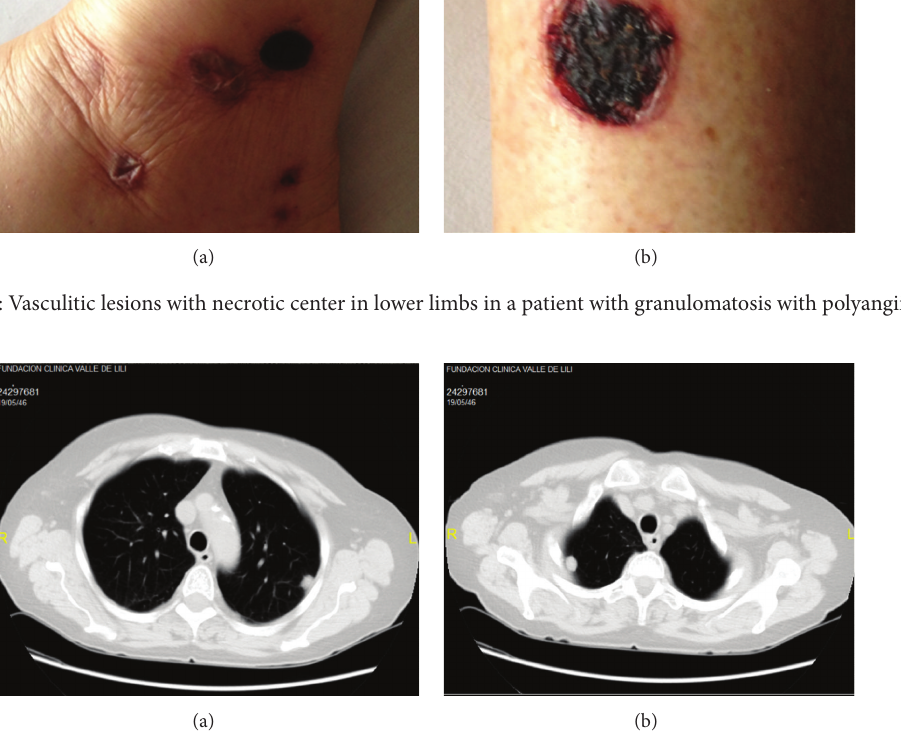
Figure 2: Pulmonary nodules seen on CT imaging of a patient with granulomatosis with